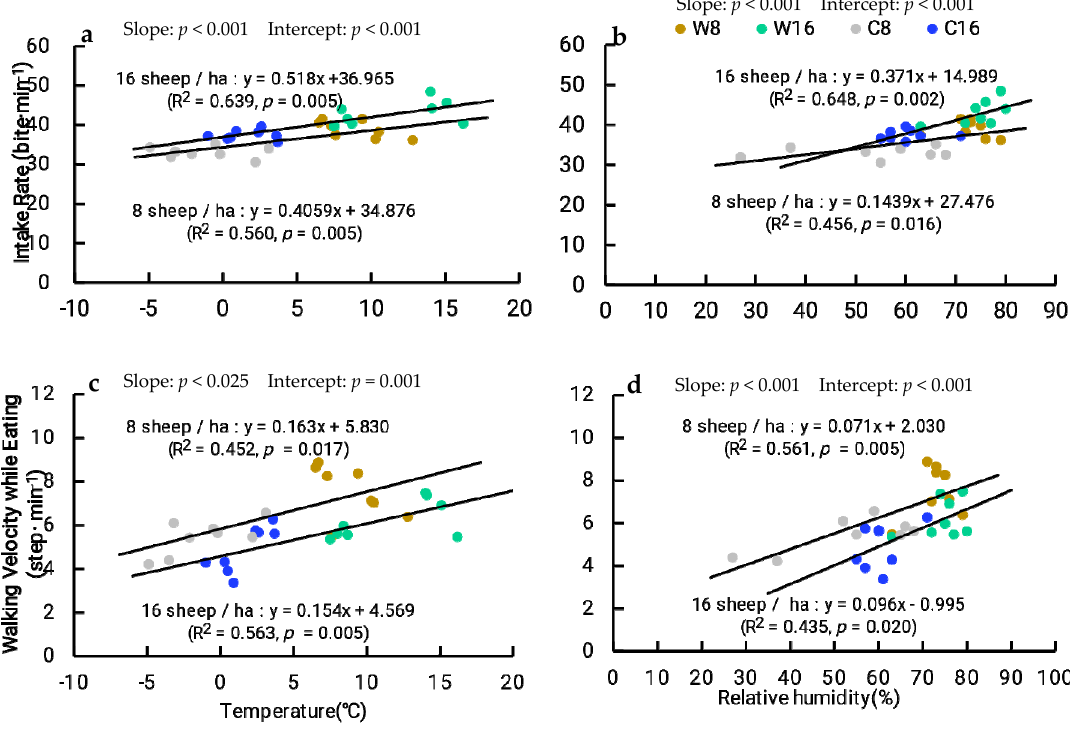
Figure 8. Relationships between ( a ) average daylight ambient temperature and intake rate, ( b ) relative humidity and intake rate, ( c ) average daylight ambient temperature and walking velocity while intaking, ( d ) relative humidity and walking velocity while intaking at the two stocking rates (8 sheep/ha and 16 sheep/ha) in the two seasons of the (warm and cold) of 2010 and 2011. The slope and intercept in the figure represent the difference between the two regression lines.